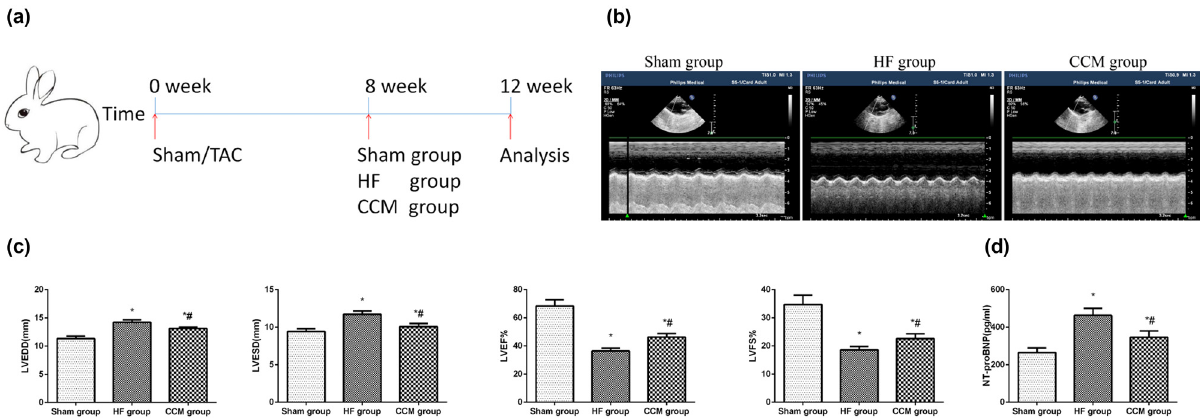
Figure 1: CCM treatment improves cardiac function in a HF rabbit model. ( a ) A time frame of the 16 - week experiment. ( b ) Representative echocardiograms in di ff erent groups. ( c ) Echocardiography analyses of LVESD, LVEDD, LVEF, and LVFS. ( d ) Detection of BNP levels by enzyme - linked immunosorbent assay ( ELISA ) . Data are expressed as mean values ± SD ( * P < 0.05 compared with the sham group; # P < 0.05 compared with HF group )